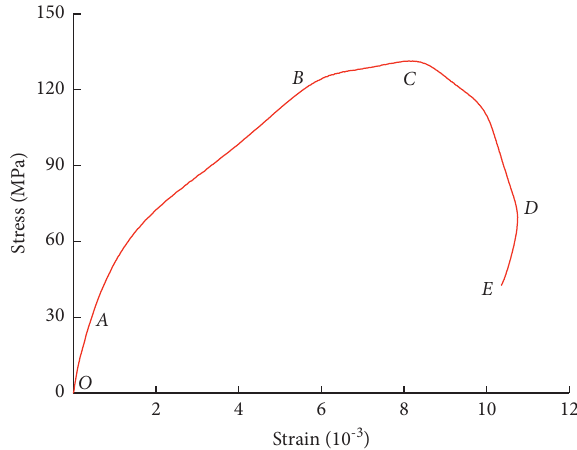
Figure 4: Impact failure stress-strain curve in SHPB test for marble.